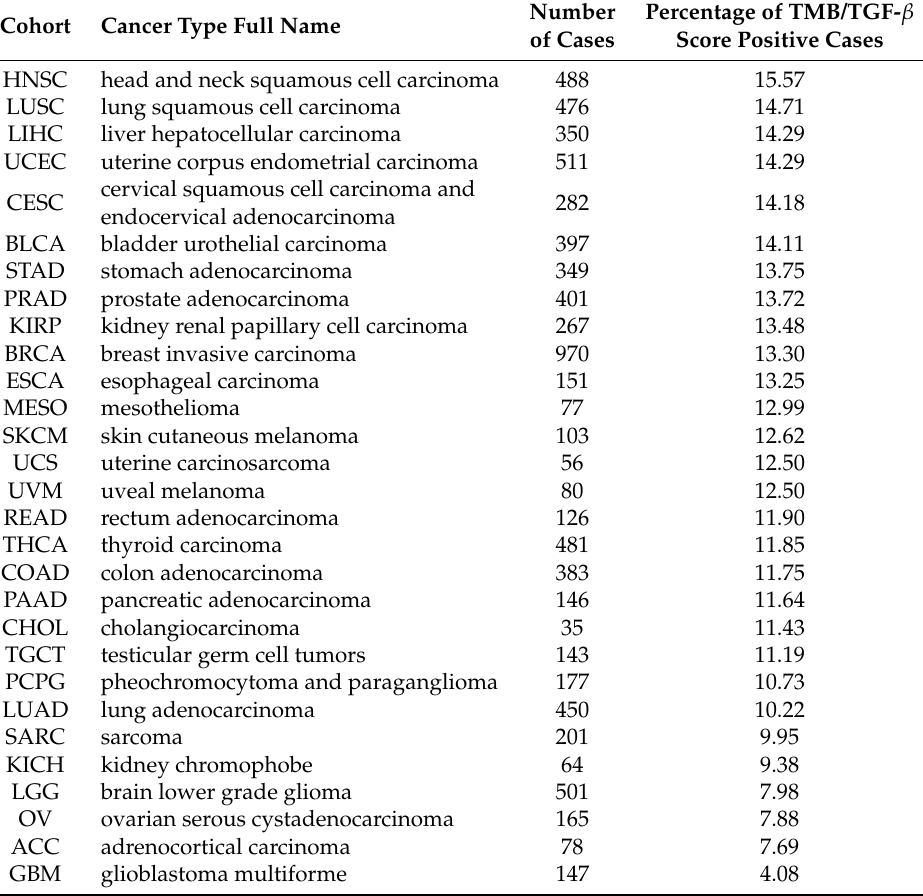
Table 1. Cases included in the study from The Cancer Genome Atlas (TCGA) cohorts for 29 cancer types and frequency of TMB/TGF- β score positive cases in the context of each cancer